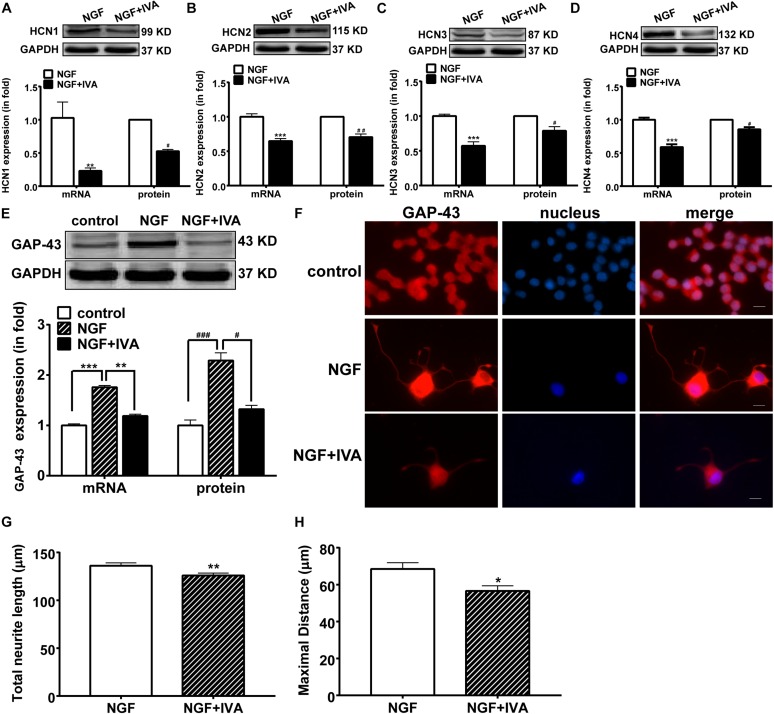
The suppressing effects of ivabradine (IVA) on the mRNA and protein expressions of HCN channel isoforms and GAP-43 and the neurite outgrowth. (A–D) Real-time PCR and western blotting results of the mRNA and protein expression levels respectively for HCN1-4 isoforms in NGF-treated PC12 cells relative to GADPH level. ∗∗p < 0.01, ∗∗∗p < 0.001 vs. NGF treatment alone in the mRNA level. #p < 0.05, ##p < 0.01 vs. NGF treatment alone in the protein level. (E) Representative western blotting bands (upper) and the mRNA and protein semiquantitative values (lower) of GAP-43 in NGF-treated PC12 cells. ∗∗p < 0.01, ∗∗∗p < 0.001 vs. NGF treatment alone in the mRNA level. #p < 0.05, ###p < 0.001 vs. NGF treatment alone in the protein level. (F) Immunofluorescent stains of GAP-43 protein (red), displaying that NGF induced, while ivabradine inhibited, the neurite outgrowth in differentiating PC12 cells. DAPI was used for cell nuclei staining (blue). Scale bar, 10 μm. (G,H) Quantitative morphological parameters of neurite outgrowth including the total neurite length and the maximal neurite length (longest process per cell). Results are calculated from three independent experiments and presented as mean ± SEM, 96 < n < 213, ∗p < 0.05, ∗∗p < 0.01 vs. NGF treatment alone.